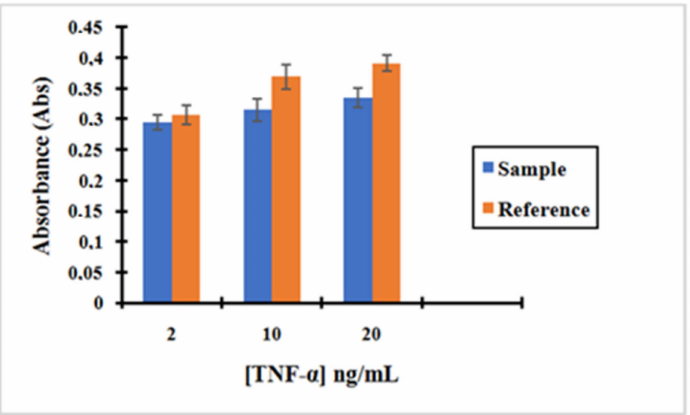
Figure 12. Bar graph showing (blue) the measurement of the absorbance after TNF- α incubation with the complex MNP@SiO 2 -NH 2 -CO-anti-TNF- α at three di ff erent concentrations of TNF- α : 2, 5, and 10 ng / L; (Orange) the measurement of the absorbance of TNF- α after incubation with no activated MNPs. Background fixed in artificial saliva at 1 / 500. Error bars correspond to three replicates per